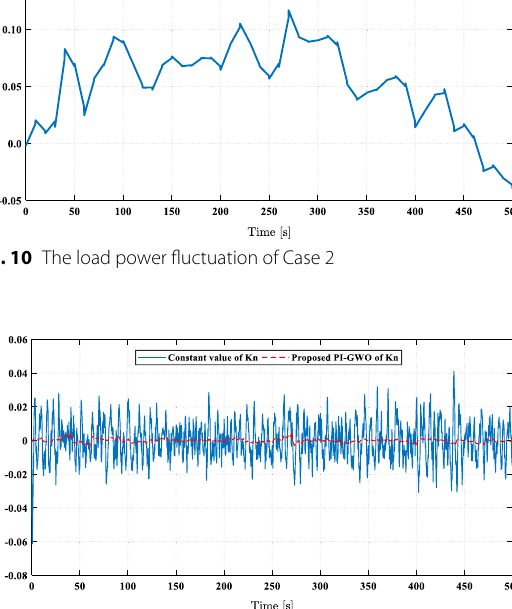
Fig. 11 The frequency deviation of Case 2